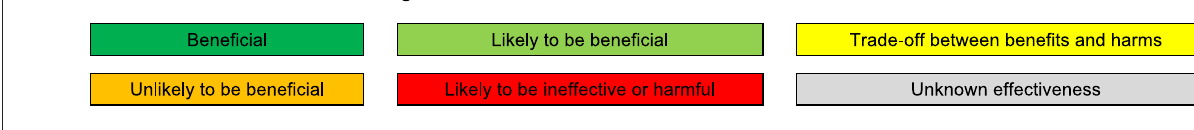
FIGURE 2 | The effects of management practices on multiple ecosystem services in California and other Mediterranean farming systems (based on the evidence summarized by Shackelford et al., 2017). The results of the evidence assessment are shown as comma-separated values in this order: benefits score , harms score, certainty score , number of summarized studies on which these scores are based (the same studies were assessed for soil and climate regulation). These scores were used as “performance measures” in the multiple-criteria decision analysis. we also used the Environmental Quality Incentives